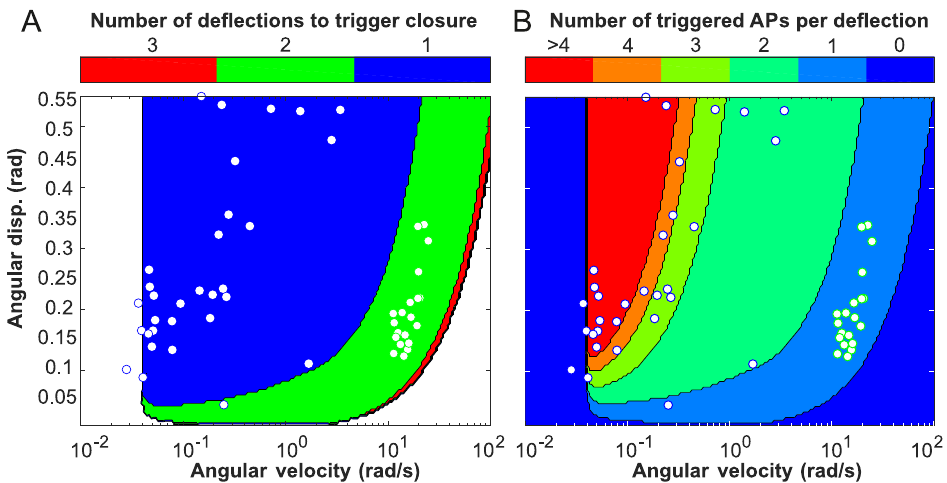
Fig 3. ECB model. (A) Prediction of the number of action potentials triggered for a single deflection with consecutive waiting time as function of angular displacement (“disp.”) θ and velocity ω , confronted with experimental observations for cases in which trap closure was triggered by single (blue circles) and double deflections (green circles). (B) Number of deflections necessary to trigger trap closure with phases of one, two, or three deflections compared to the findings for single- (blue circles) and double-deflection (green circles) experiments. For the underlying data, see sheet Figs 3A and B in S1 Data. ECB, electromechanical charge buildup.